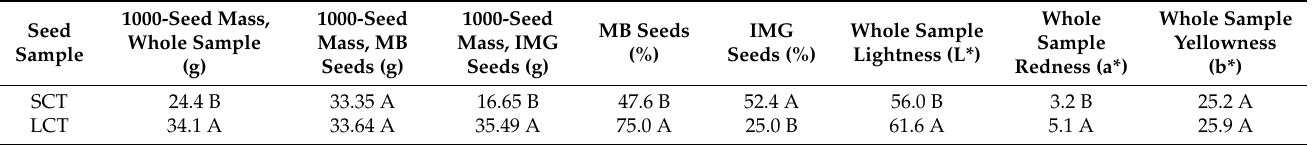
Table 1. Visual characteristics and mass of 1000 lentil seeds based on the seed maturity (MB and IMG seeds) of SCT and LCT lentil